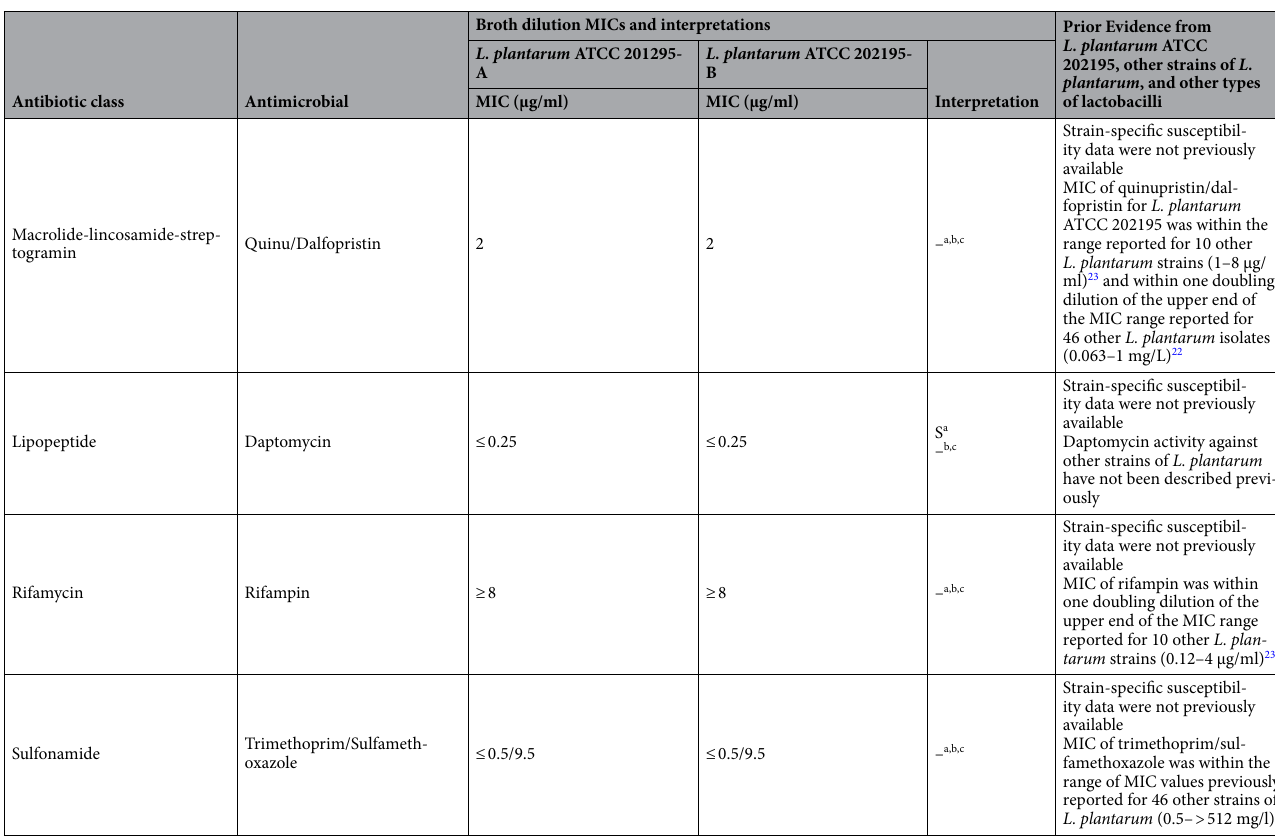
Table 1. Antimicrobial susceptibility and minimum inhibitory concentrations of L. plantarum ATCC 202195-A and L. plantarum ATCC 202195-B. Clinical breakpoint interpretations were categorized as susceptible ("S"), intermediate ("I"), resistant ("R"), no interpretive criteria available ("–”), and insufficient evidence (“IE”). a Interpretation based on CLSI, b EFSA, and on c